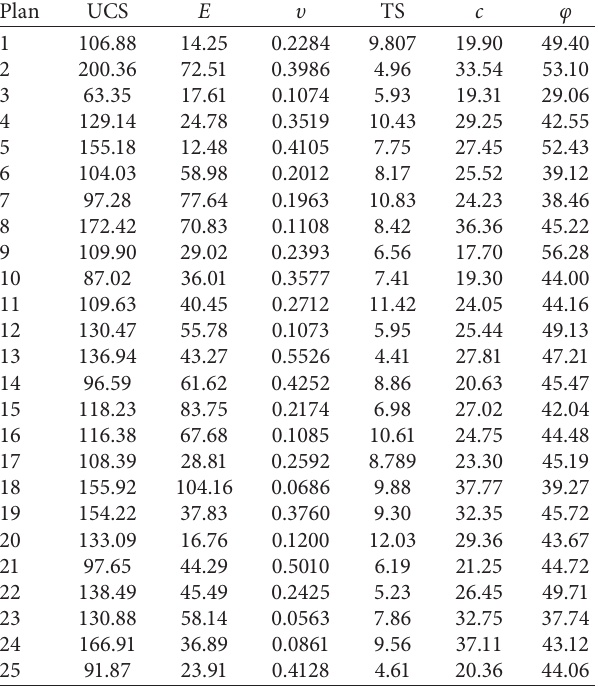
Table 13: Calculated macroparameters of orthogonal test. Plan